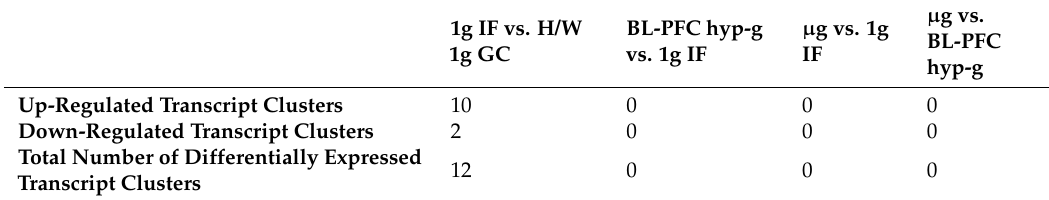
Table 9. Differentially expressed oxidative stress-related transcript clusters in T cells during the 23rd parabolic flight campaign. Number of significantly differentially expressed transcript clusters that were up-regulated or down-regulated in the respective comparison. Differential expression is defined as t -test p -value < 0.05; fold change (FC) < − 1.3 or > +1.3. FCs are ratios between the averages of linear expression values. If the ratio is <1, FC is calculated as the negative reciprocal of the ratio. A total of 106 transcript clusters, belonging to 86 genes involved in oxidative stress response, were investigated. For the abbreviations of the experiment group names see Table 1.